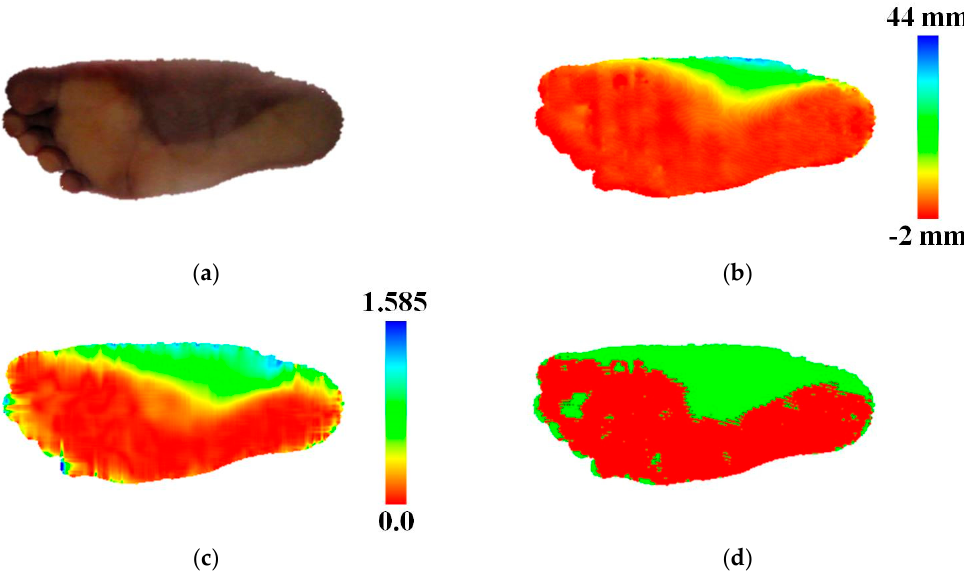
Figure 6. Example of MRF-based contact region detection: ( a ) color image of the foot points ( b ) visualization of distance between the foot points and the estimated footplate, ( c ) visualization of the angle between the normal vectors of the footplate and the points, ( d ) MRF-based segmentation (red: contact region, green: non-contact region, and white: background).